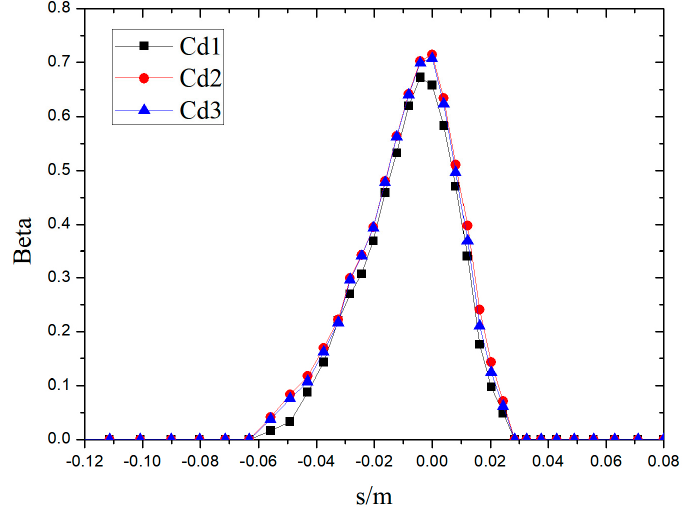
Figure 11. Comparison of the ice crystal collection coe ffi cients for the di ff erent drag models.